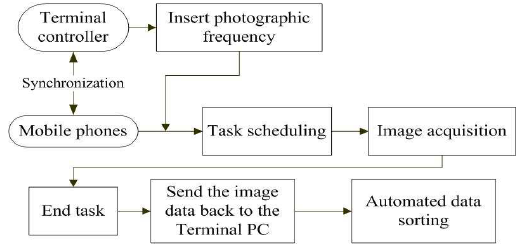
Figure 1: Operational processes of in-house software.